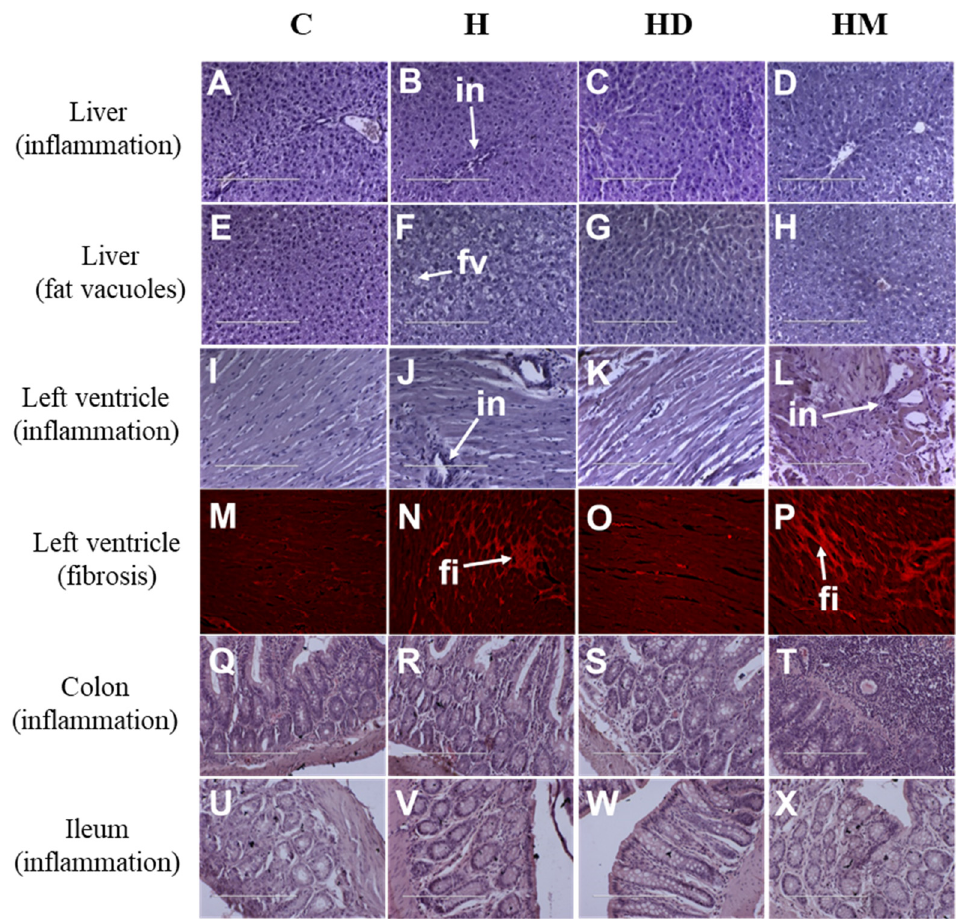
Figure 2. Effects of Oedogonium grown in ash dam water and treated municipal wastewater on inflammation and fibrosis in the heart, colon and ileum structure of rats ( n = 4 rats per group). Hematoxylin and eosin staining of the liver showing inflammatory cells ( in , arrow head) and fat vacuoles ( fv , arrow head) in C ( A , E ); H ( B , F ); HD ( C , G ) and HM ( D , H ) rats. Hematoxylin and eosin staining and picrosirius red staining of the left ventricle showing inflammatory cells ( in , arrow head) and fibrosis ( fi , arrow head), respectively, in C ( I , M ), H ( J , N ), HD ( K , O ) and HM ( L , P ) rats. Hematoxylin and eosin staining of the colon and ileum showing inflammatory cells in C ( Q , U ), H ( R , V ), HD ( S , W ) and HM ( T , X ) rats. Scale bar, 100 μ m. C, corn starch diet-fed rats; H, high-carbohydrate, high-fat diet-fed rats; HD, high-carbohydrate, high-fat diet-fed rats supplemented with Oedogonium grown in ash dam water; and HM, high-carbohydrate, high-fat diet-fed rats supplemented with Oedogonium grown in treated municipal wastewater.